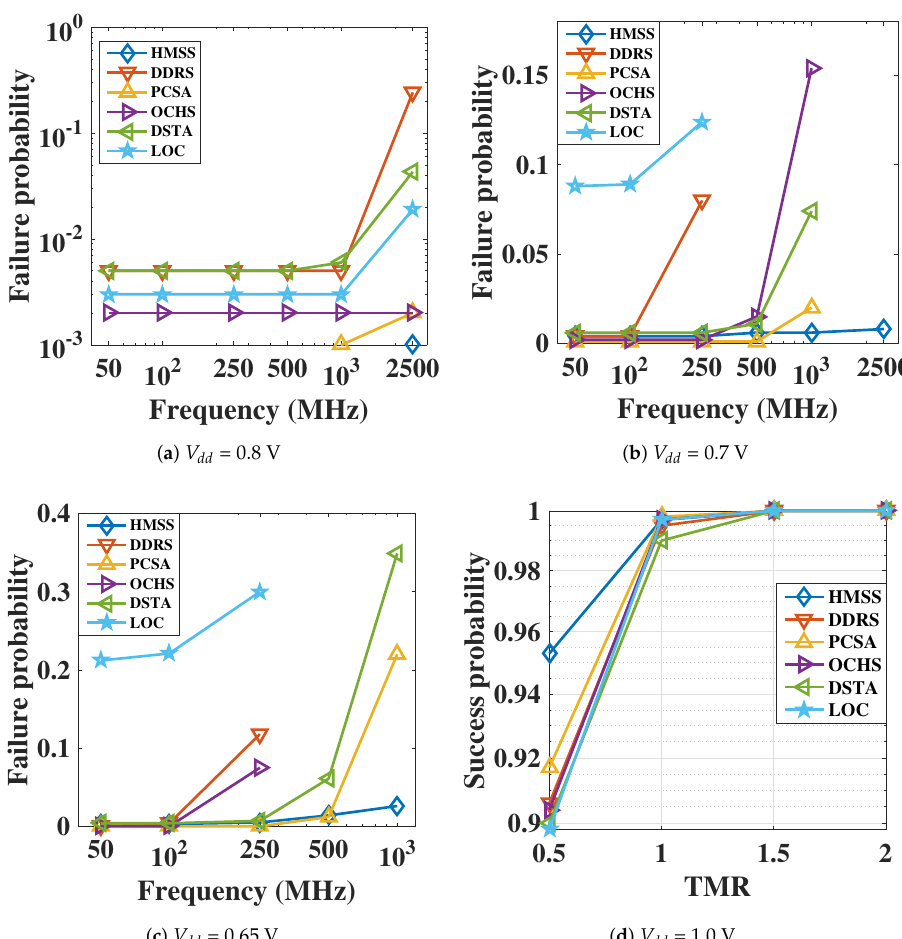
Figure 8. ( a – c ) Sensing failure probability versus sensing frequency at different V dd node. TMR=100%. ( d ) Successful sensing probability versus MTJ TMR at 1V V dd . HMSS achieves an improved sensing rate even that the TMR was as low as